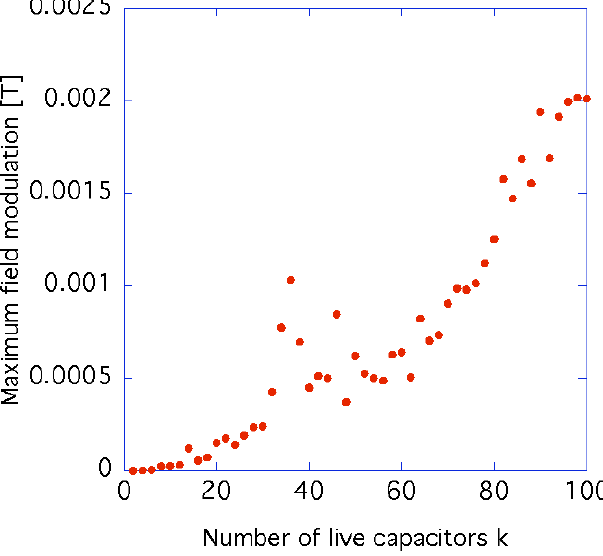
FIG. 29. (Color) The dependence of the maximum field modu- lation on the number of working capacitors k when the measured field pattern (that is given by the left of Fig. 16) is